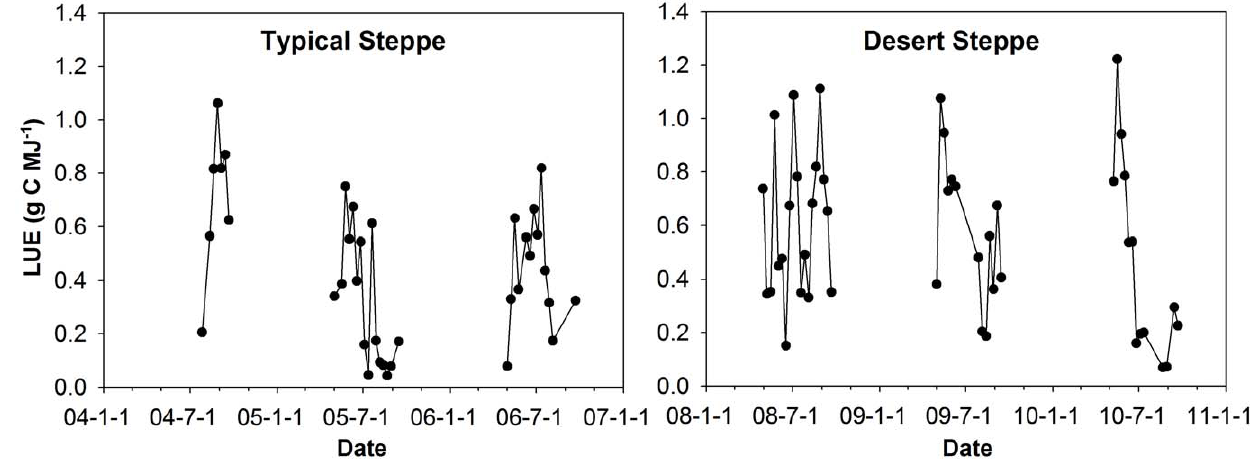
Figure 4. Seasonal variations of light use efficiency (LUE) at the two sites. LUE was calculated by dividing GPP by PAR a (FPAR*PAR).